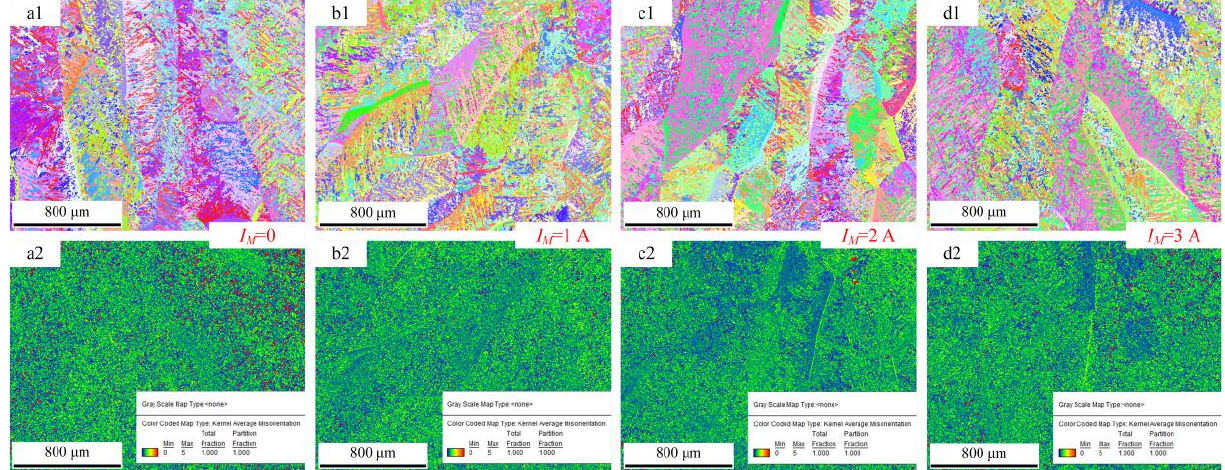
Figure 9. Grain morphology and misorientation of cross-section of the deposition layer obtained by using wire feeding speed of 4 m/min. (Note: ( a1 , a2 ) MIG, ( b1 , b2 ) M-MIG with magnetic excitation current of 1A, ( c1 , c2 ) M-MIG with magnetic excitation current of 2A, ( d1 , d2 ) M-MIG with magnetic excitation current of 3A, the number 1 and 2 are expressed respectively the grain morphology and misorientation).